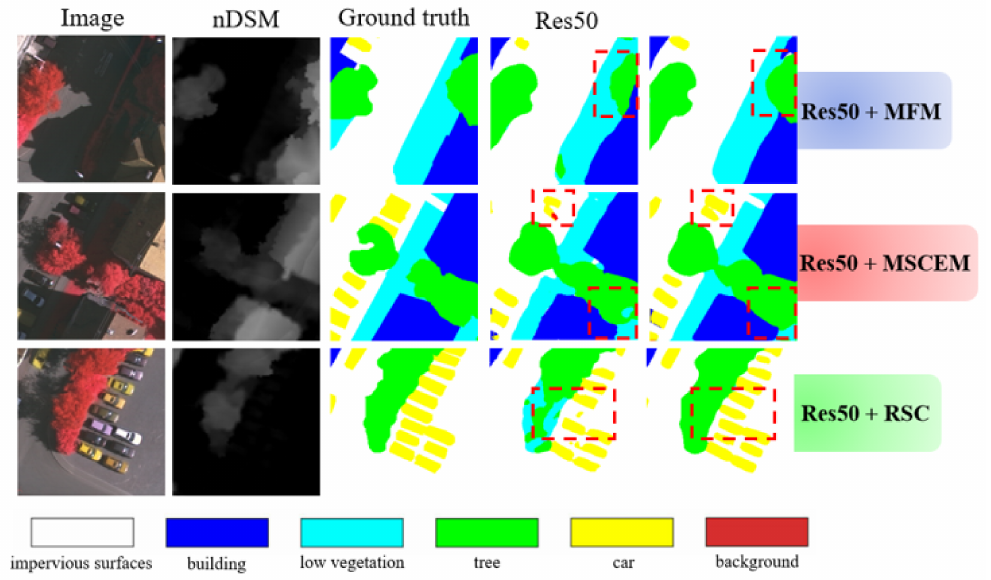
Figure 11. Comparison of ablation experiment results of different modules. The first row is a visual comparison between the baseline and the result of adding the multi-modality fusion module. The second row shows that the results verify the benefits of the multi-scale spatial context module. The third row shows the visualization results of the baseline using the residual skip connection